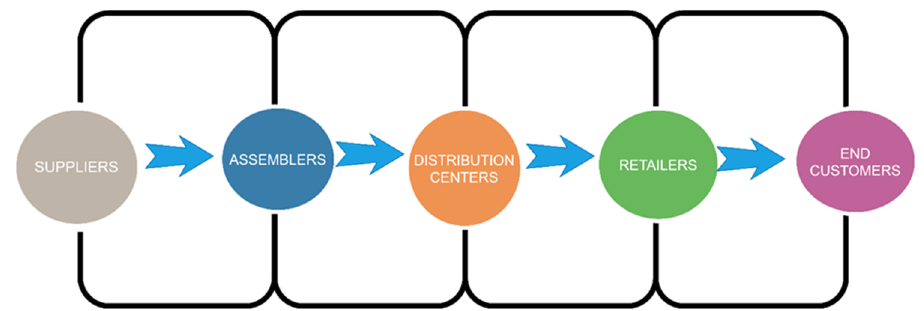
Figure 6. Framework of classical supply chain network design.